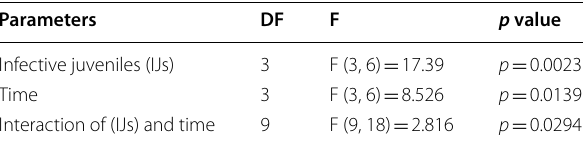
Table 4 Parameters assessed Mean mortality percentages of Helicoverpa armigera larvae infected with isolate Steinernema abbasi CS39 at different